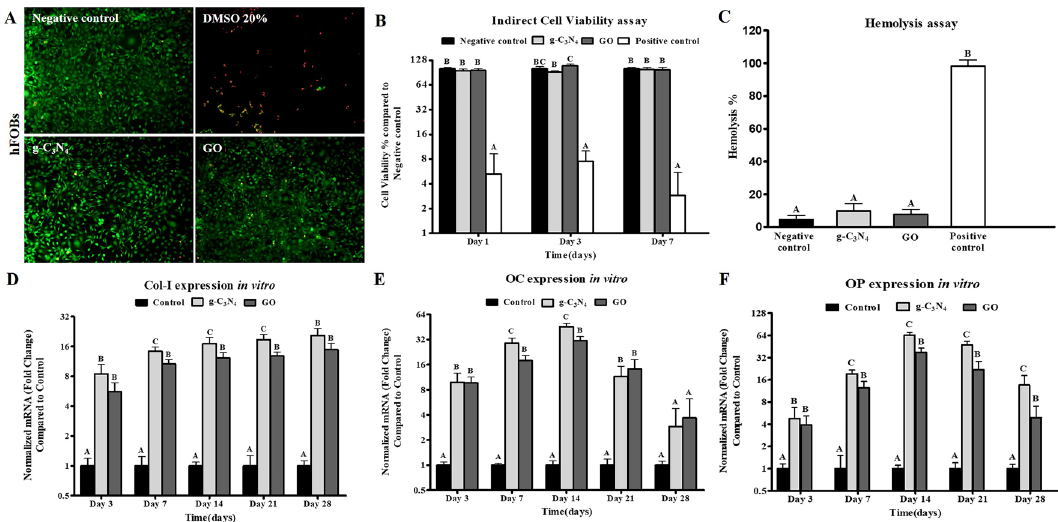
Figure 2. In vitro experiments of g-C 3 N 4 and GO. ( A ) Cell viability using Live/Dead assay for hFOB cells cultured on g-C 3 N 4 and GO nanomaterials for 7 days. Live cells were stained green and dead cells were stained red (Scale bar represents 100 µm, Magnification = 10 ×). ( B ) MTT cytotoxicity assay for cell viability of hFOB cultured using extracts of g-C 3 N 4 and GO nanomaterials for 1, 3 and 7 days compared to the negative control. Error bars represent means ± standard deviation (n = 8). ( C ) Hemolysis assay using extracts of g-C 3 N 4 and GO nanomaterials compared to the negative control. q-PCR analysis for mRNA expression of collagen type 1 (Col-1) ( D ), osteocalcin (OC) ( E ), and osteopontin (OP) ( F ) in negative control cells and on g-C3N4 and GO nanomaterials for 28 days, respectively. Error bars represent means ± SD; n = 3 for each group and time point. Bars with the same letter represent not significantly different values (one-way ANOVA followed by Tukey’s HSD post hoc